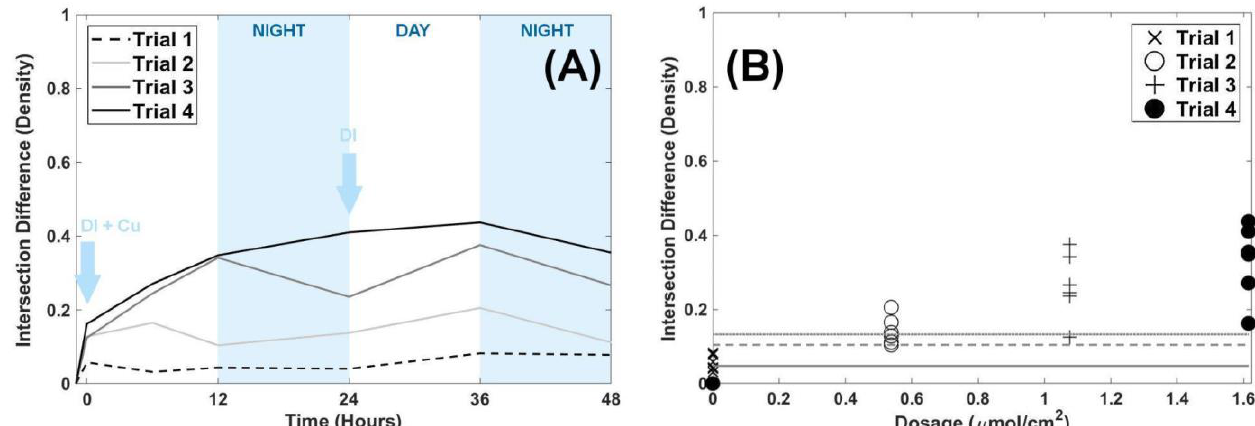
Figure 5. ( A ) Plot of intersection density difference over time in hours ( A ) and by dosage ( B ) for each trial over the first 48 h. Blue arrows indicate dosing on day 1 and day 2 of the experiment. For the control trial 1, these doses were both 30 mL of DI water. For all other treated trials, the day 1 dose was a Cu and DI solution at 30 mL. The day 2 dose was just 30 mL of DI.